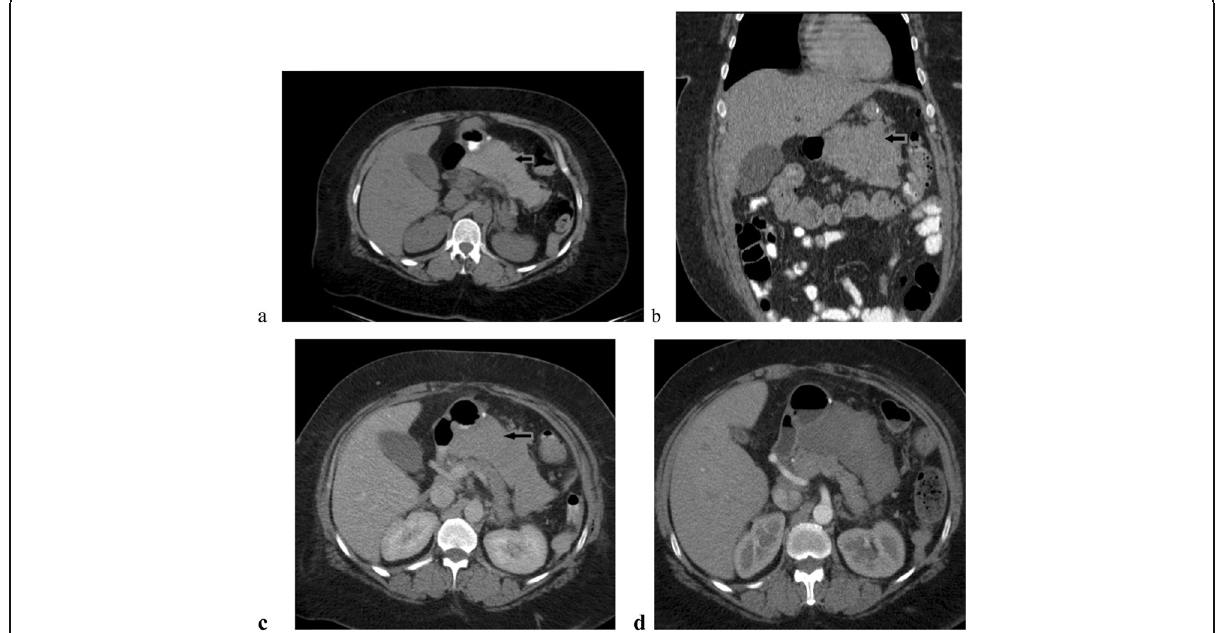
Fig. 7 A thirty-nine-year-old female patient with BMI of 42 kg/m 2 was presented 4 days post-lap. sleeve gastrectomy by abdomen pain and tachycardia. UGS shows no abnormality. a , b MSCT axial and coronal reformatted images revealed a large irregular walled extraluminal high- density fluid collection at the operative bed with soft tissue stranding of the surrounding fat. d Follow-up CT after 2 weeks shows a stationary course of the previously depicted operative bed collection. Diagnosis: perigastric hematoma